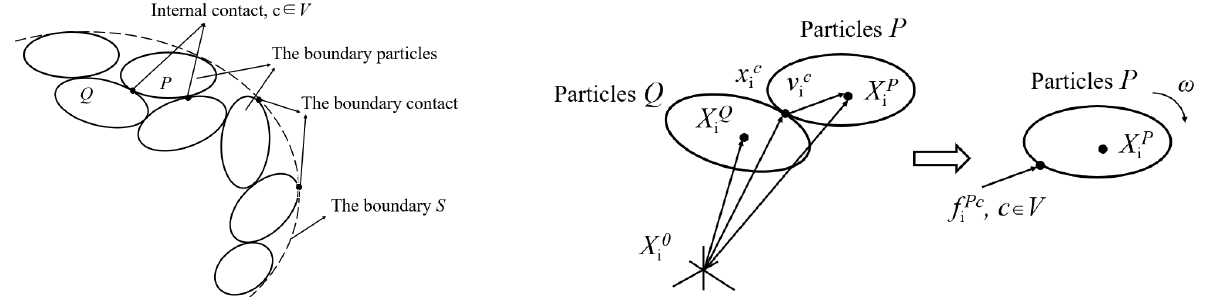
Figure 13. Diagram of particle–boundary interaction.